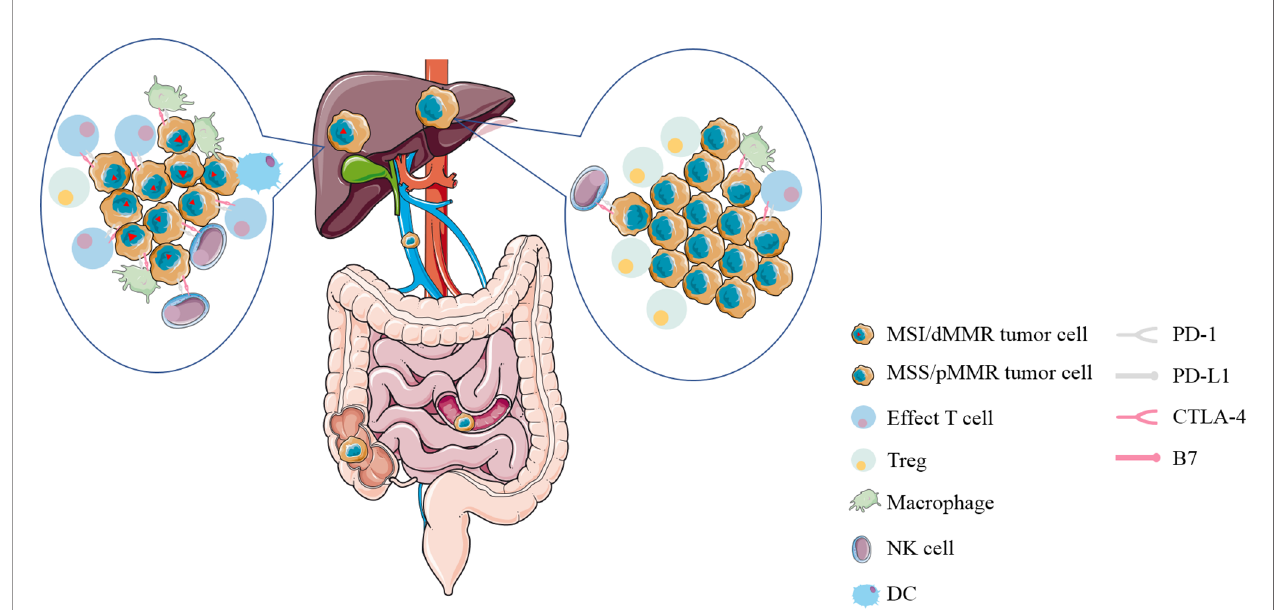
FIGURE 2 | The immune microenvironment of liver metastases from colorectal cancer with MSI/dMMR or MSS/pMMR. Immune cells (CD8+ in fi ltrating lymphocytes; CD4+ TILS; macrophages; NK cells) are abundant in MSI-H/dMMR tumors and inhibitory checkpoint molecules on the surface of lymphocytes and tumor cells (PD- 1, PD-L1, respectively) are increased correspondingly. MSI/dMMR, microsatellite instability/mismatch-repair-de fi ciency; MSS/pMMR, microsatellite stability/mismatch- repair-pro fi ciency; CTLA-4, cytotoxic T-lymphocyte-associated protein 4; PD-1, programmed cell death 1; PD-L1, PD-1 ligand; Treg, regulatory T cell; DC, dendritic cell; NK cell, natural killer